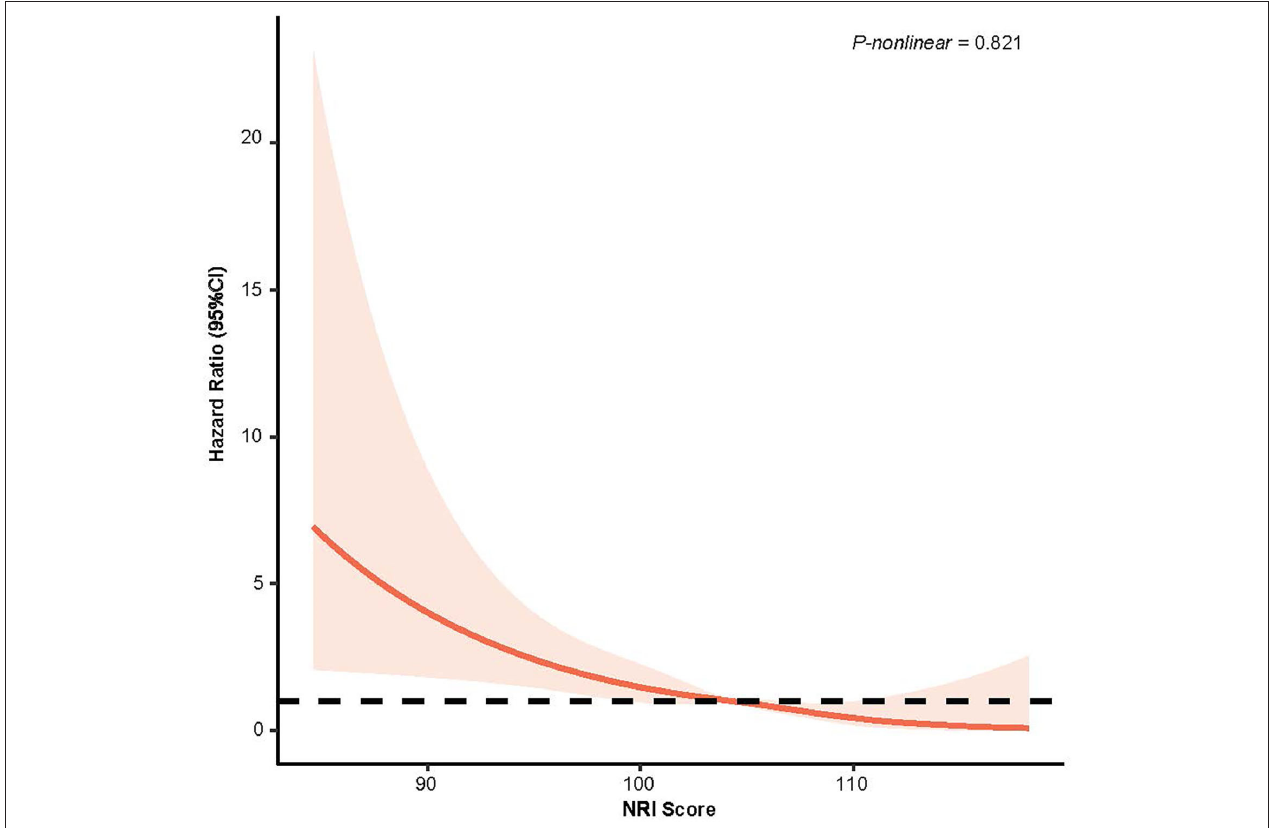
FIGURE 3 | Restricted Cubic Splines of Hazard Ratio (HR) and 95% CI for the association between NRI score (continuous) and all-cause mortality